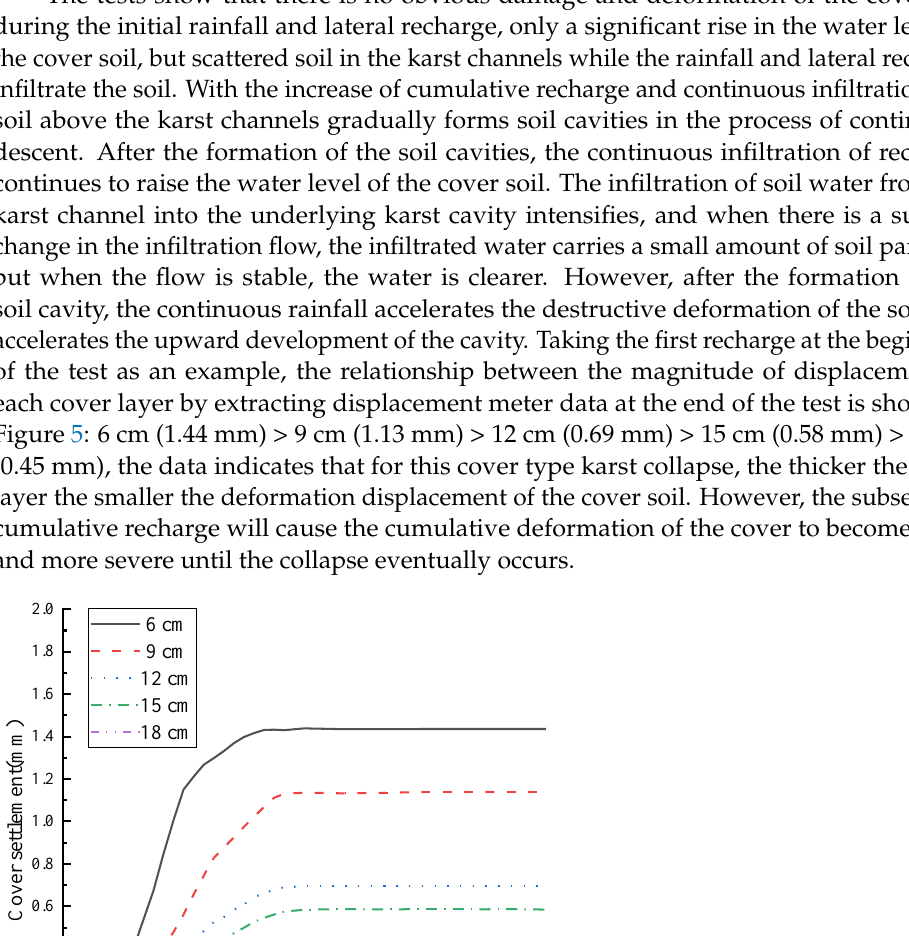
Figure 5. The relationship between rainfall and caprock